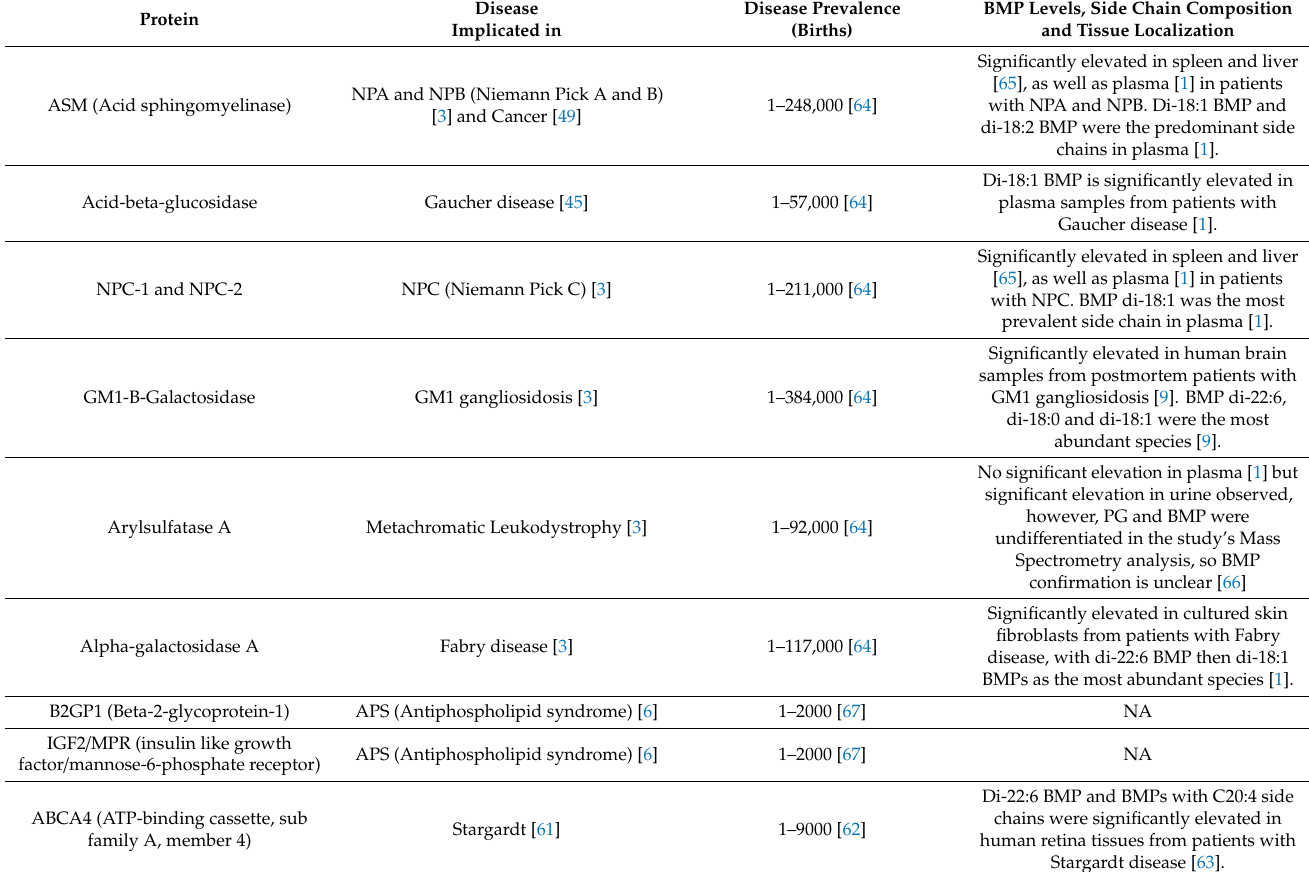
Table 1. BMP-associated diseases and proteins implicated in disease progression.